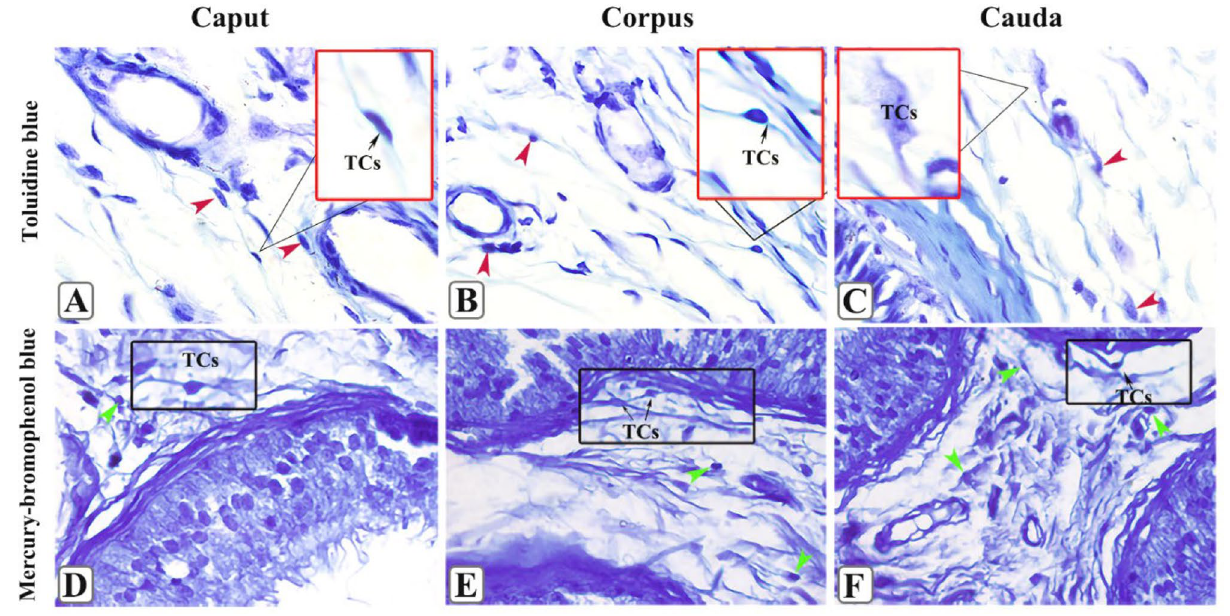
Figure 7. The toluidine blue and mercury–bromophenol blue staining of yak epididymis. Toluidine blue staining results of yak caput epididymis ( A ), corpus epididymis ( B ), and cauda epididymis ( C ). The distribution of TCs in the interstitium of epididymis surrounds the capillaries. The red arrow refers to telocytes, which are clearly visible. The photographs of mercury–Bromophenol blue staining in yak caput epididymis ( D ), corpus epididymis ( E ), and cauda epididymis ( F ). The cytoskeleton and TPs of TCs were stained dark blue by bromomercury phenol blue, and the green arrow indicates TCs. The morphology was clearly